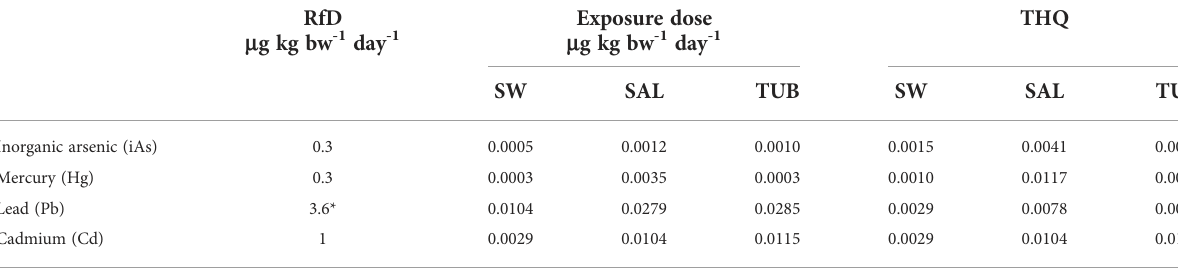
TABLE 6 Estimated exposure dose and target hazard quotient (THQ) when consuming 5.2 g dw of Ulva fenestrata cultivated for 14 days in the seawater control (SW), and the two herring production process waters salt brine (SAL) and tub water (TUB).